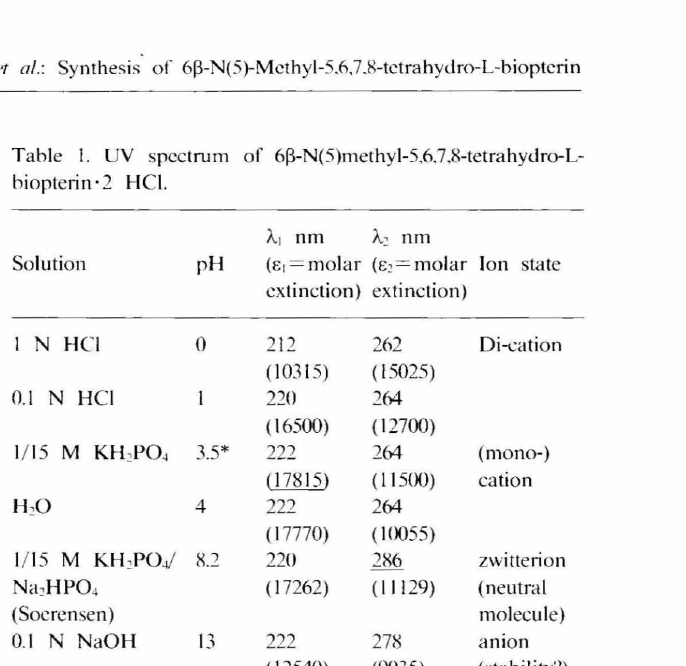
Table I. UV spectrum of 613-N(S)methyl-S.6.7.8-tetrahydro-L biopterin' 2 Hel.